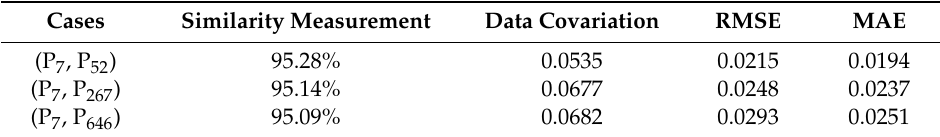
Table 8. Statistical analysis of the new case 7 and retrieved top three similar past cases.